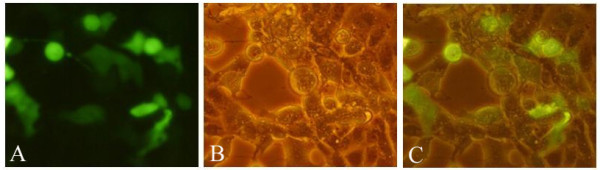
Expression of the fused EGFP-VP2 protein in Vero cell foci detected by fluorescence microscopy (magnification 400 ×). (A) Fluorescence microscope image of PRV SA215/VP2 infected Vero cells 36 h post-infection; (B) Light microscope image of PRV SA215/VP2 infected Vero cells 36 h post-infection; (C) Merged images of (A) and (B).